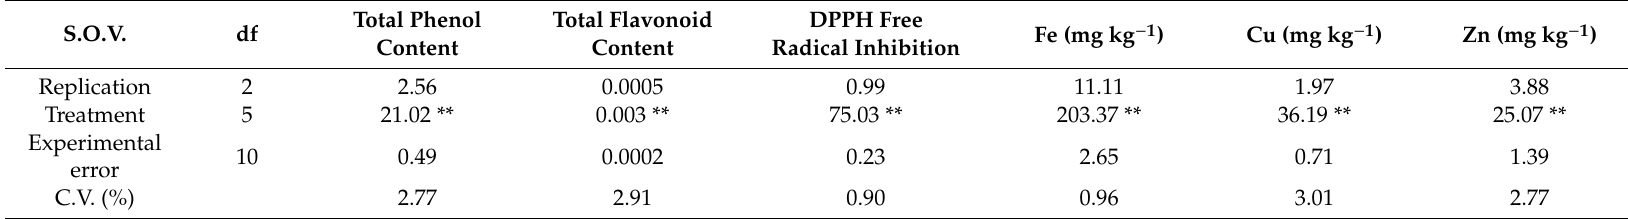
ns, ** show insignificance and significance at p < 0.01,